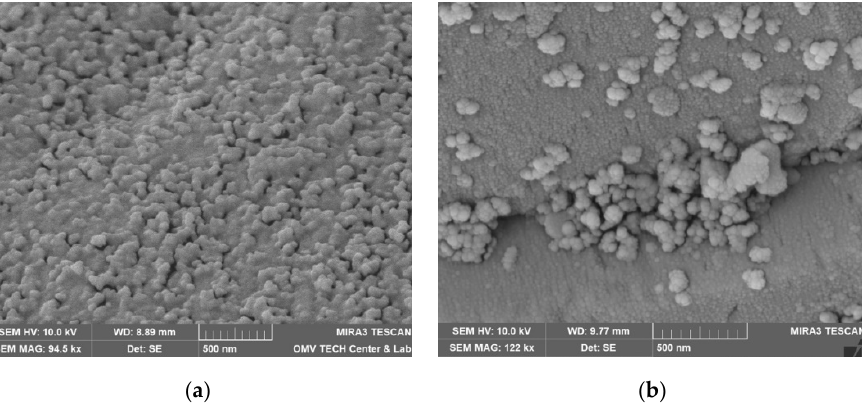
Figure 23. Scanning electron microscope (SEM) images measured for the core material used in this work. This comparison shows a rock sample that has been vacuum saturated ( a ) and a core flood sample ( b ). Both samples have been treated with 1 wt% nanofluid B in test water; however, bigger particle agglomeration can be seen in the core flood image.